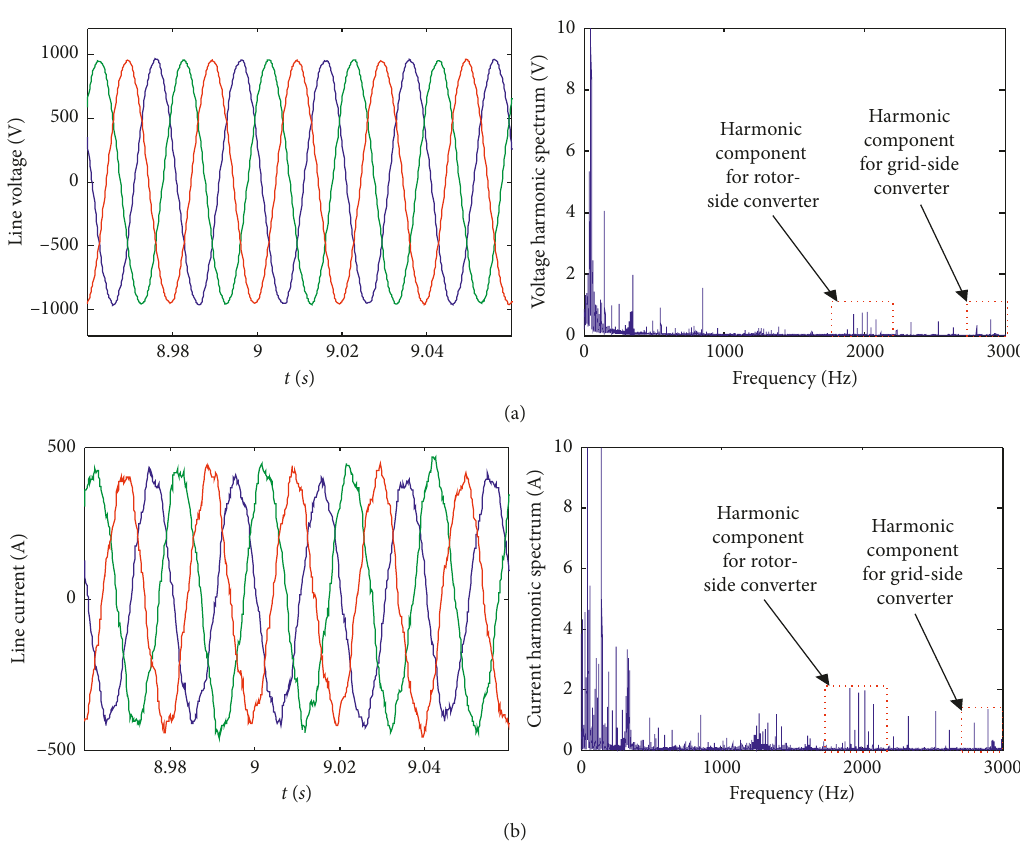
Figure 16: (a) Voltage waveform and harmonic spectrum and (b) current waveform and harmonic spectrum of the DFIG at